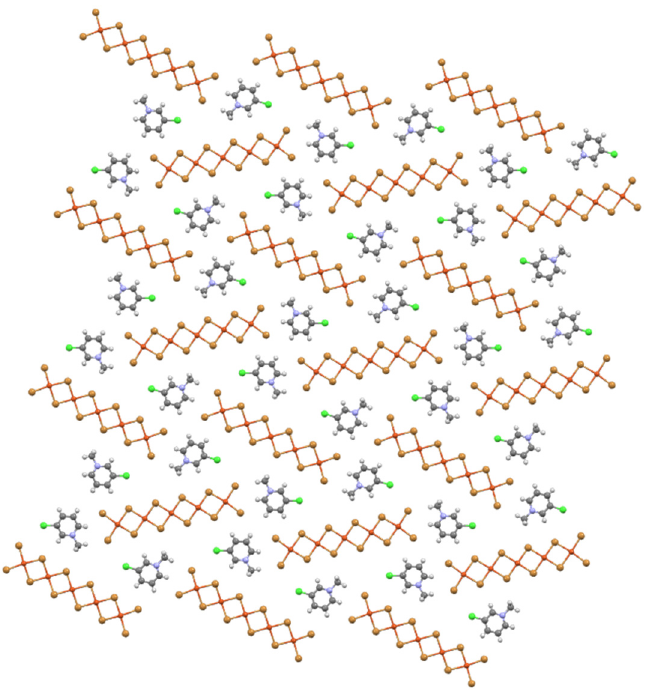
Figure 11. Ball-and-stick diagram of the mixed organic cation/oligomer sheet in (3-chloro-1- methylpyridinium) 2 Cu 5 Br 12 (AKEJOQ) viewed perpendicular to the (103) plane.